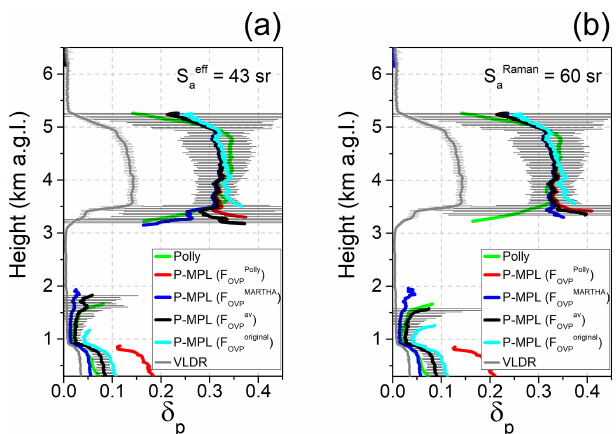
Figure 6. The same as Fig. 5, but for the vertical particle linear depolarization ratio (PLDR), δ p , as retrieved from each β p [ F OVP ] as shown in Fig. 5 and the VLDR, δ V (grey line). The corresponding Polly-retrieved δ p profile is also included (green line). For clarity, ] (black) and δ Polly error bars are only marked for δ p [ F av p OVP